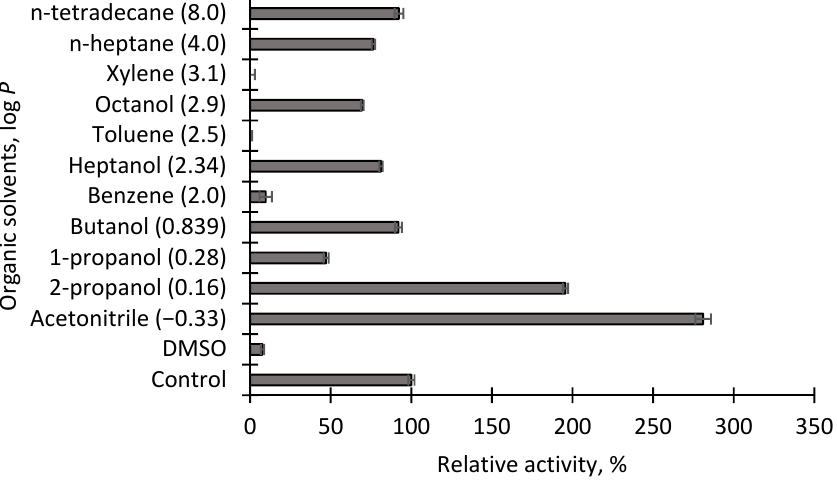
Figure 8. Effect of organic solvents on immobilized EstD9. The error bar indicates the standard deviation of triplicate assays ( n = 3).